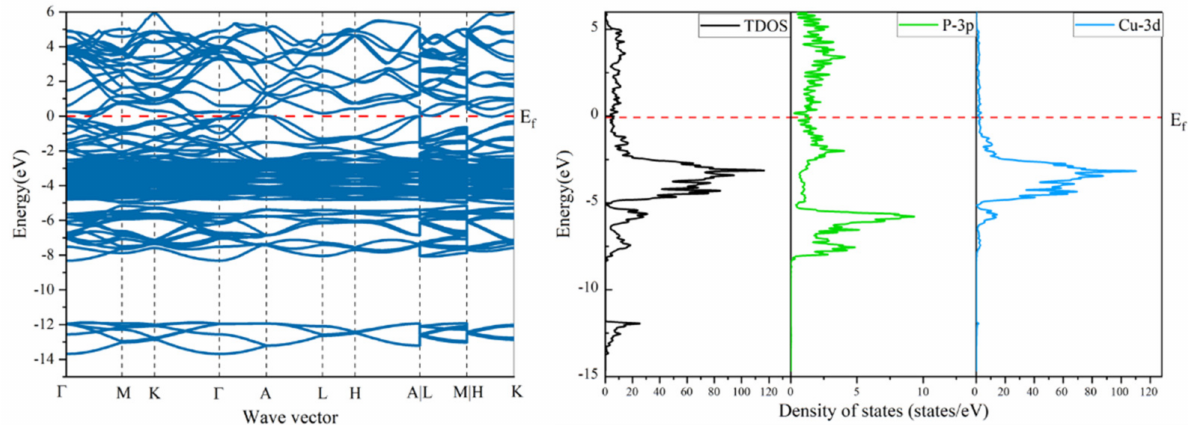
Figure 10. Calculated band structure and density of states of bulk Cu 3